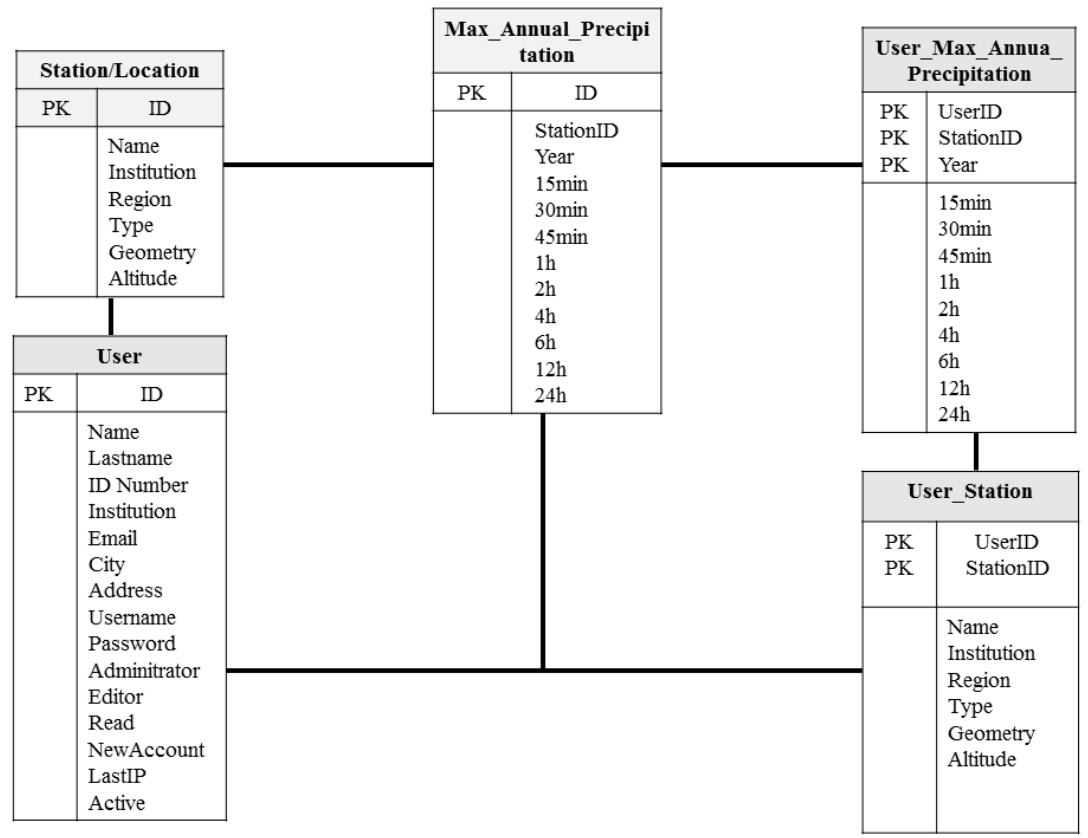
Figure 3. Geodatabase included in WEBSE IDF . PK refers to Primary Key Fields that link the ID across different tables.